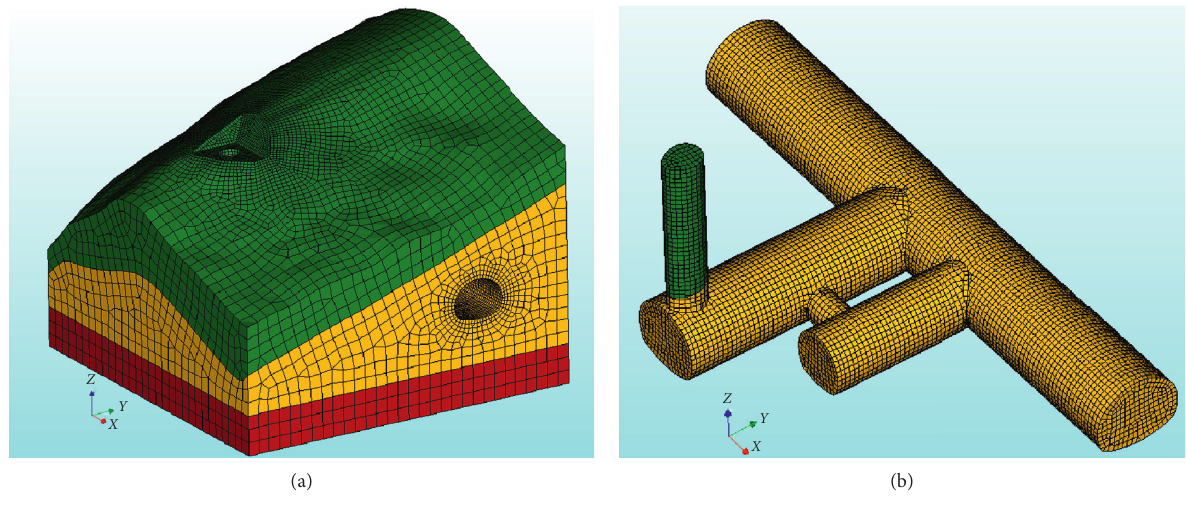
Figure 15: Finite element mesh for tunnel